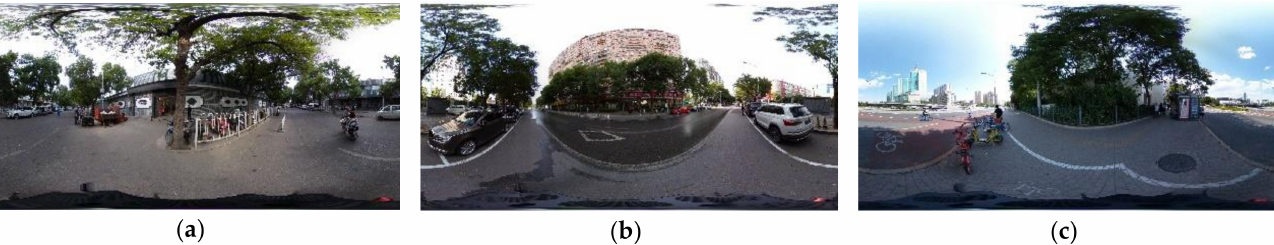
Figure 1. Examples of the street scene panoramic images: ( a ) small street scale; ( b ) medium street scale; ( c ) large street